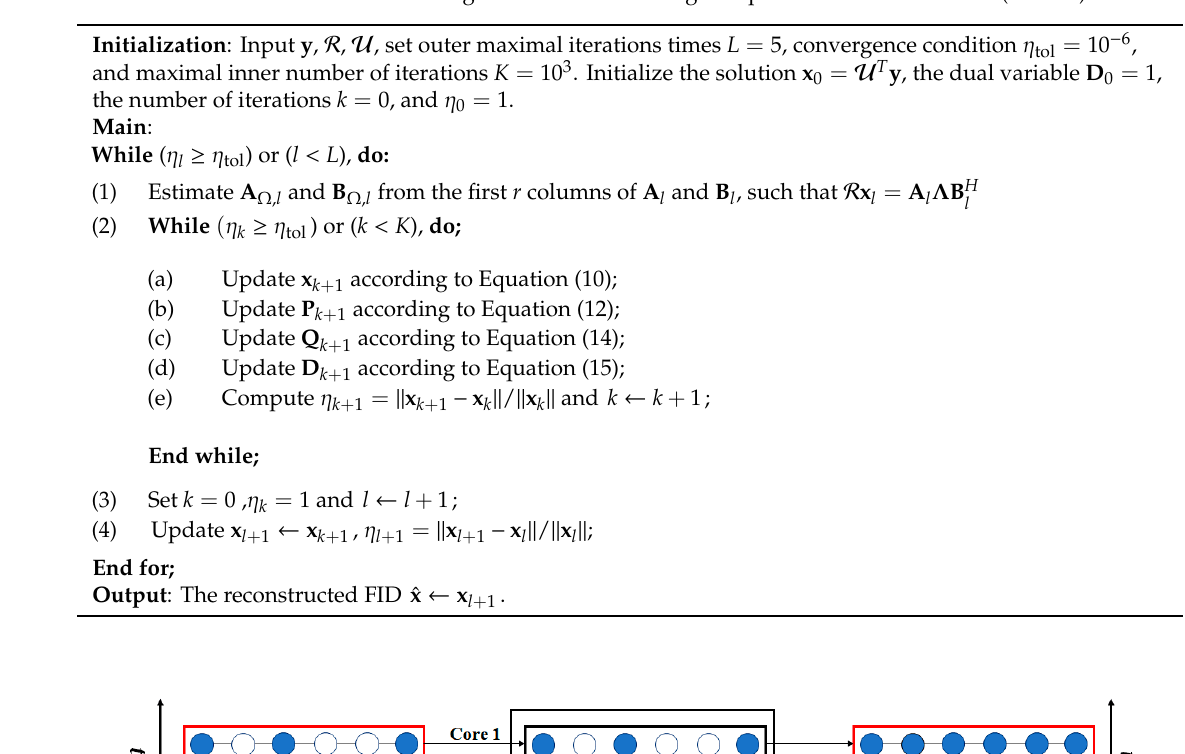
Table 1. The reconstruction algorithm of self-learning subspace matrix factorization (SLSMF).